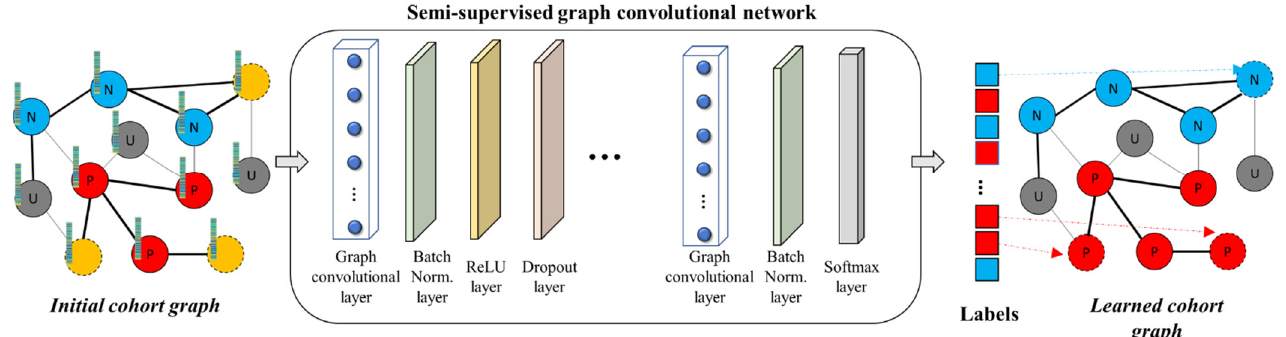
Figure 3. Architecture of the semi-supervised graph convolutional network (GCN) model. The model learns the whole cohort graph and outputs labels for individual nodes/subjects. Our GCN model consists of L hidden graph learning blocks and a final output block with a SoftMax layer for classifying graph nodes. Labeled samples are marked blue and red, Unlabeled samples are marked gray. New samples are marked yellow. P: positive, N: negative, U: unlabeled.